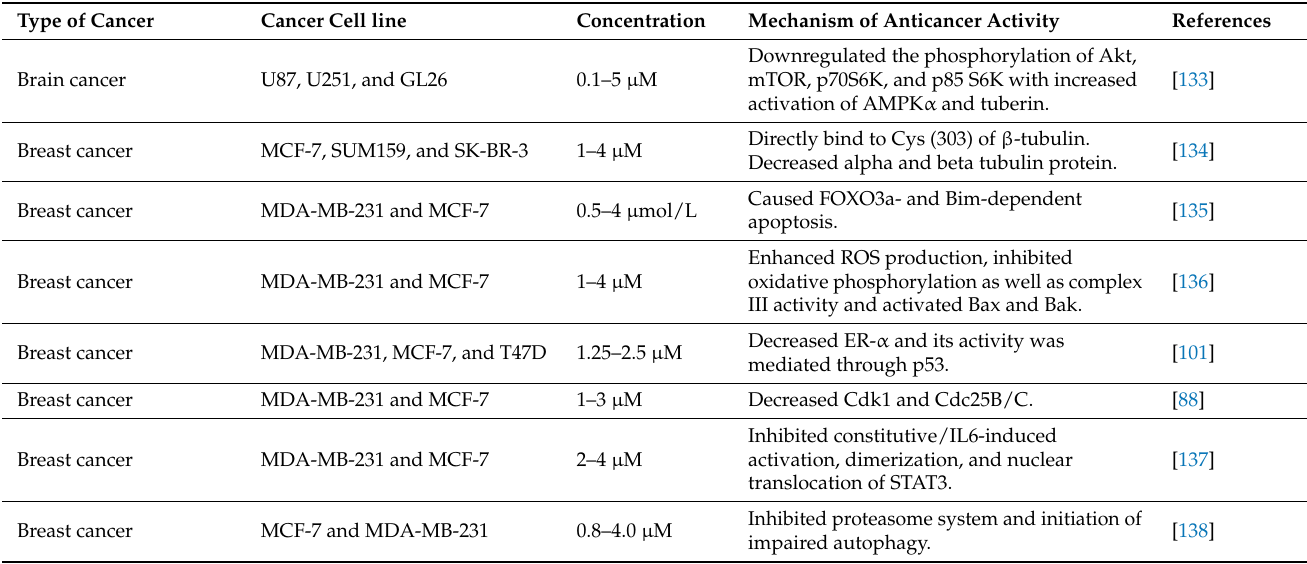
[104]. Therefore, various antineoplastic properties of withaferin A, as presented in Tables multifaceted anticancer properties of withaferin A, marking the therapeutic importance of this plant-based natural compound.